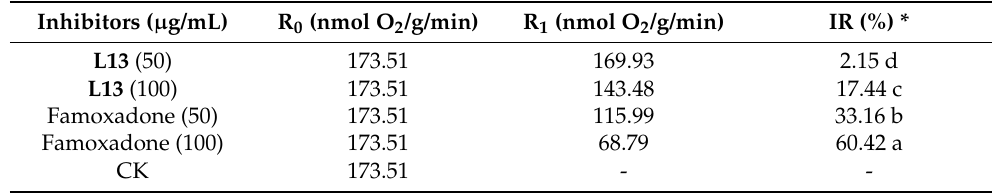
Table 2. Respiratory inhibition of intact mycelia of B. cinerea by L13 .